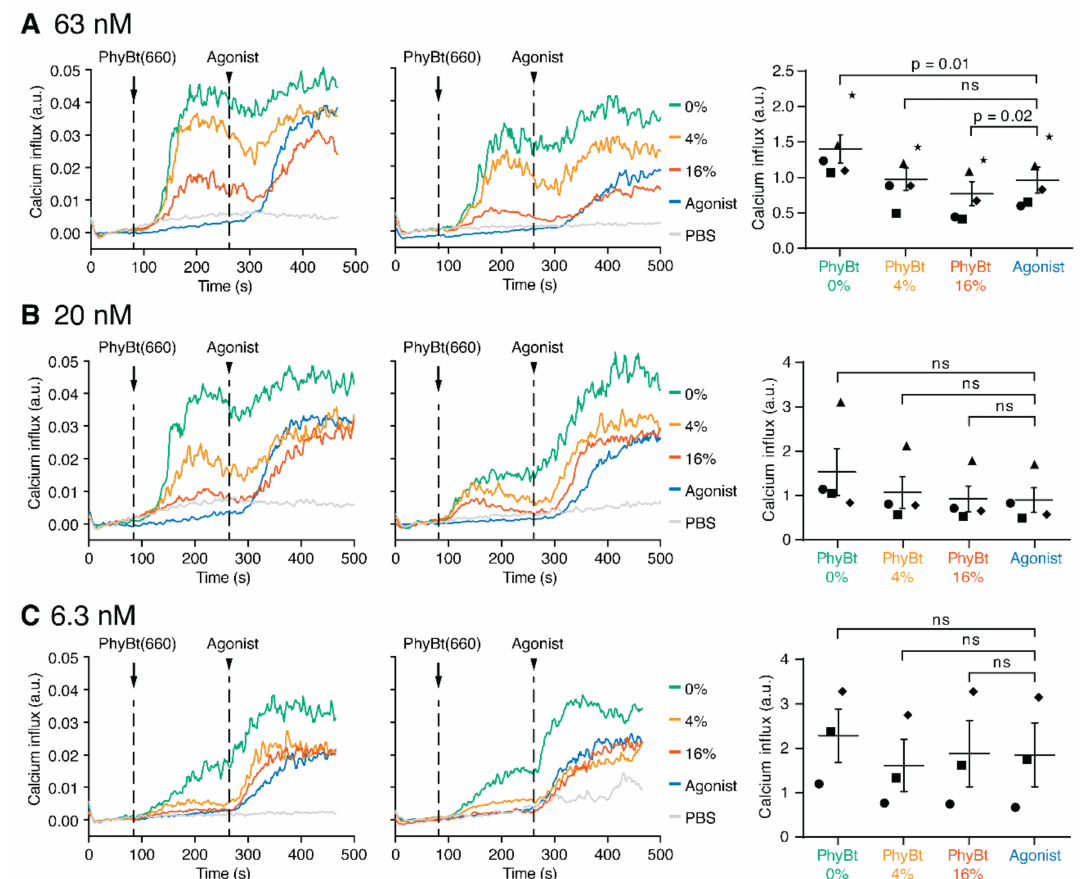
Figure 5. The antagonist concentration determines the extent of cross-antagonism. ( A ) JK82 cells were first stimulated with 63 nM PhyBt(660) (arrow) under 0%, 4% or 16% 660 nm light intensities and then with 50 ng/mL agonist (anti-V β 8, arrowhead) while measuring calcium influx using flow cytometry. Additionally, cells were treated with PBS or agonist alone as in Figure 3. ( B ) As in ( A ), but using 20 nM PhyBt. ( C ) As in ( A ), but using 6.3 nM PhyBt. Two representative experiments of n = 5 (in A ), n = 4 (in B ) and n = 3 (in C ) as well as the quantification of all experiments are shown. The different symbols of the quantification depict different